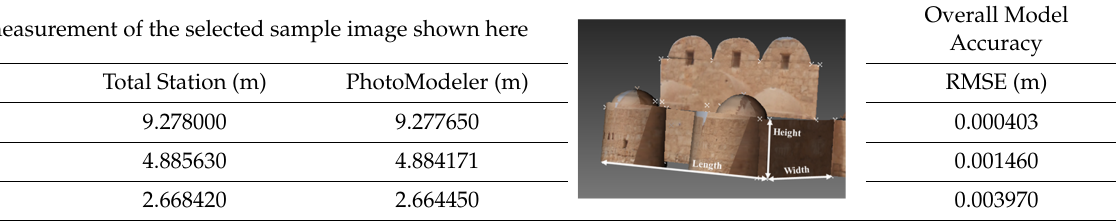
Table 4. Dimensional measurement results of Qaser